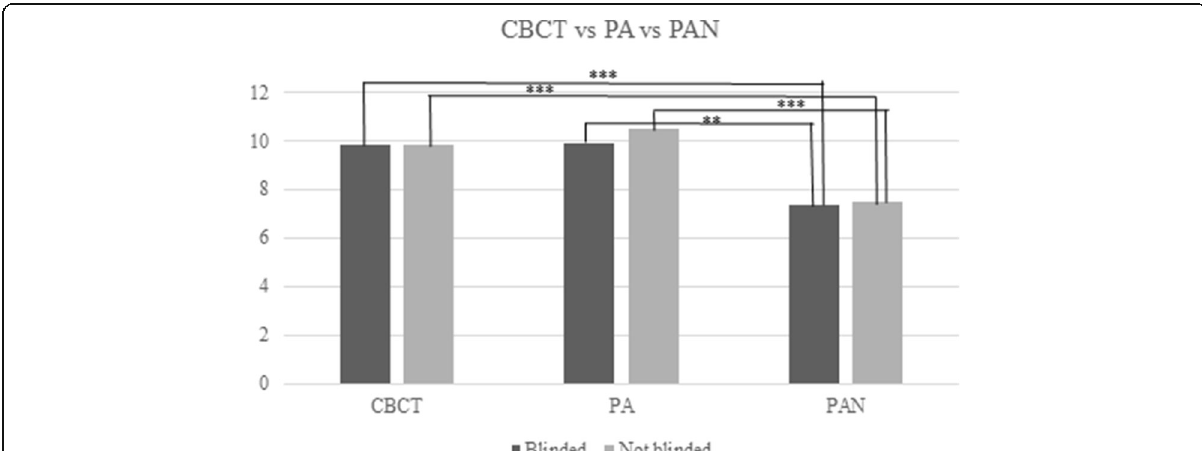
Fig. 6 Comparison of linear measurements for CBCT, periapical radiographs (PA), and panoramic radiographs (PAN). PAN differed significantly in both blinded and not blinded ( p < 0.001) compared to CBCT. Similarly, PAN differed significantly in both blinded ( p < 0.01) and not blinded ( p < 0.001) compared to PA